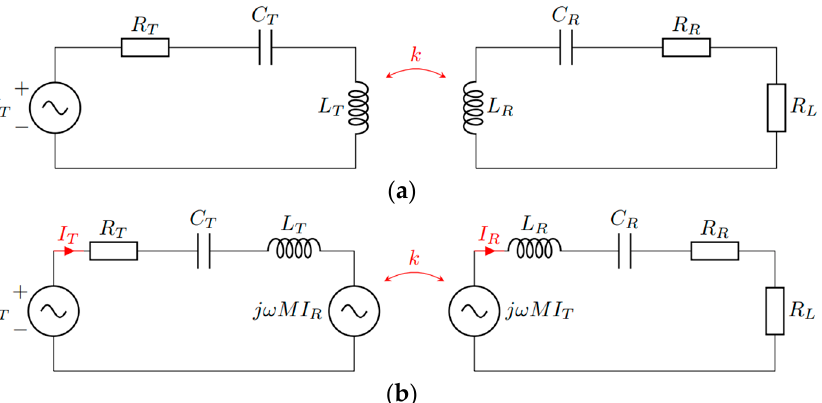
Figure 3. Simplified circuit of the IPT system: ( a ) simple circuit, ( b ) representation using induced